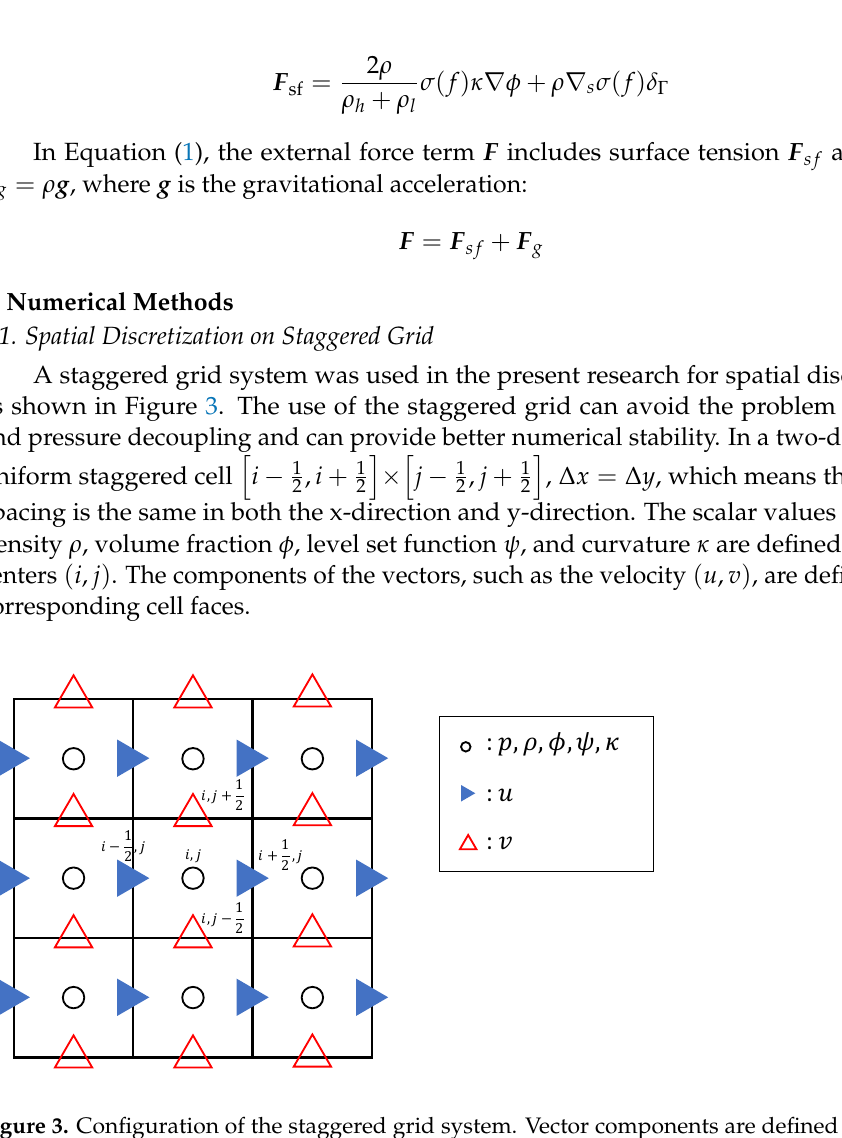
Figure 3. Configuration of the staggered grid system. Vector components are defined at cell faces, and scalars are defined at cell